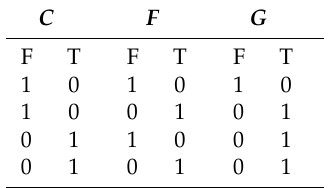
Figure 1. Seven-node DAG of system G . Table 1. CPT of node G .